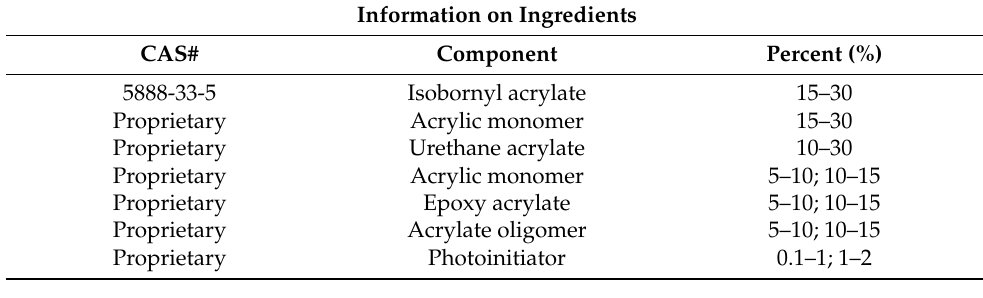
Table 1. Composition of MED610 material [45].